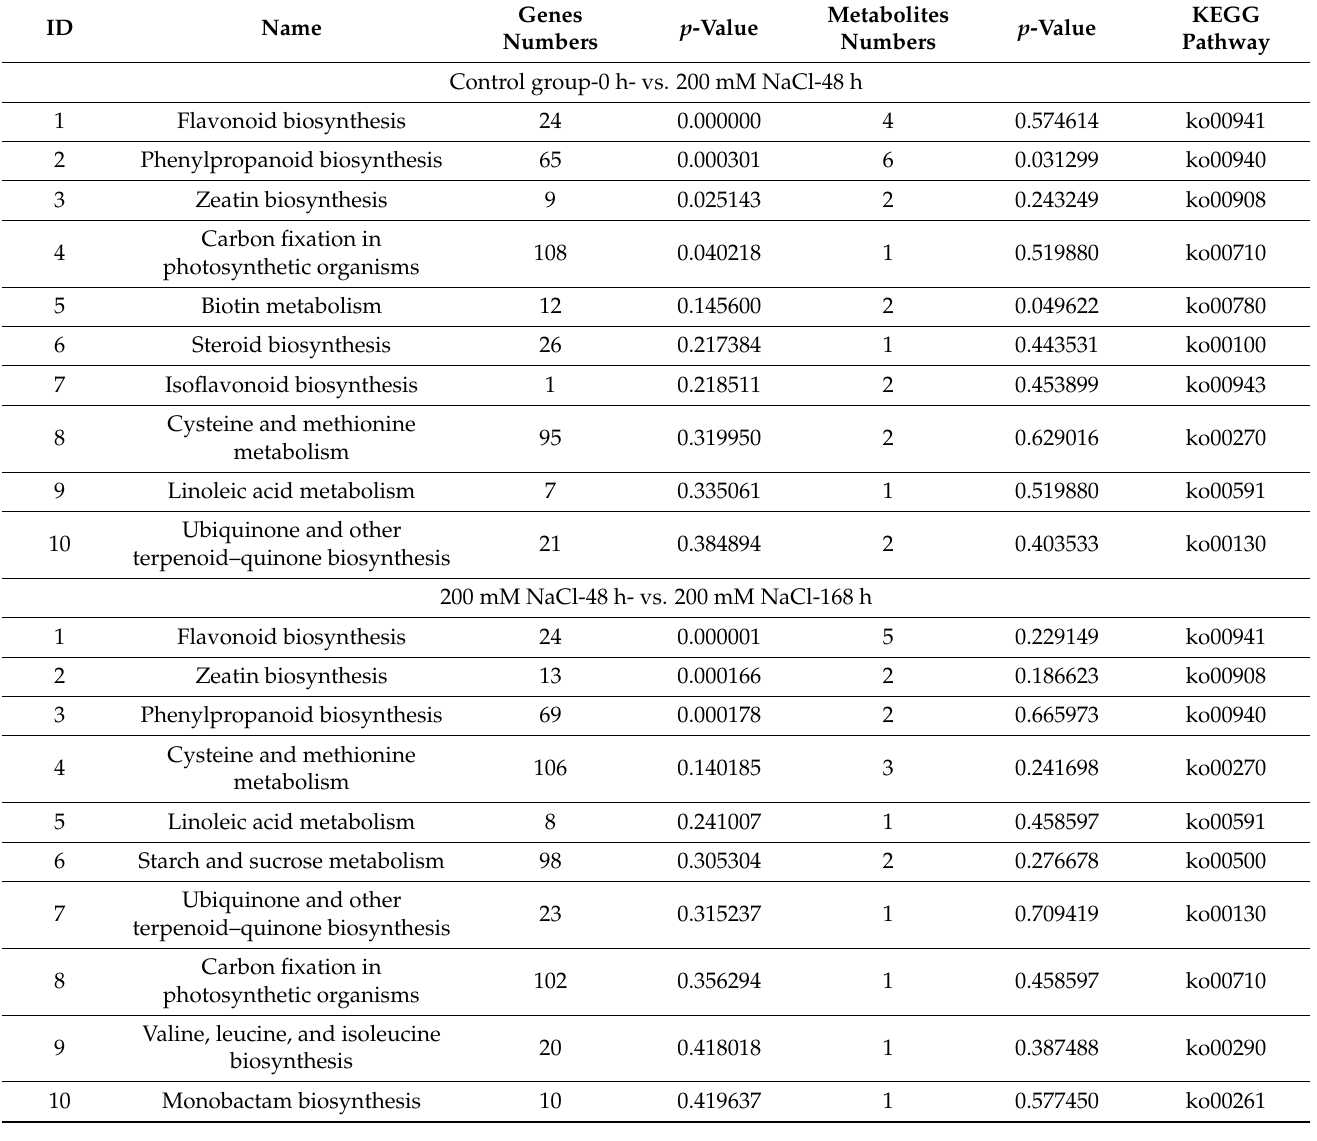
Table 2. Top 10 KEGG